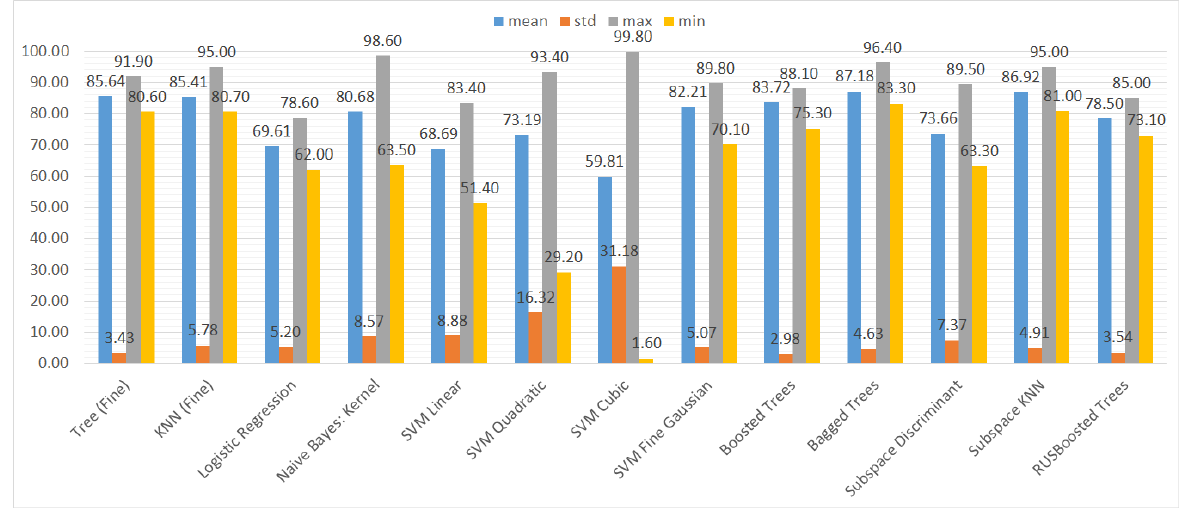
Figure 12. Mean, standard deviation, maximum, and minimum of the specificity (TNR) results for different types of